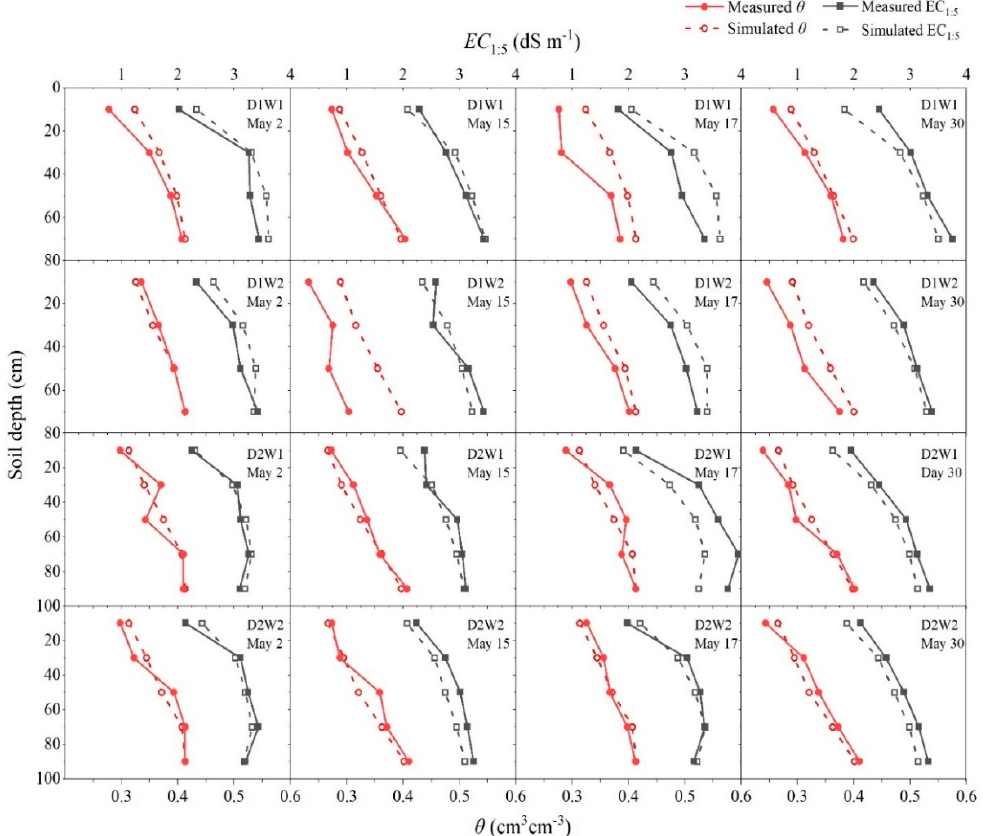
3.2. Water Movement and Salt Distribution. As shown in Figure 5, the intensity of velocity vectors in soil profile shows a negative relationship with the distance between soil profile and drain outlet. In the SDM leaching system, the seepage face was only set on the vertical boundary of the outlet (Figure 1), and this outlet was also the interface between SDM and outside air. Thus, the horizontal movement of soil water in the SDM could be the synergistic effect of pressure head combined with the high permeability of maize straw, and meanwhile the influence of pressure head on water flow mainly concentrated on the seepage face boundary which, in turn, caused a gradual decrease of the soil water velocity with the increase in the distance between the soil profile and the drain outlet. Such a phenomenon is different from